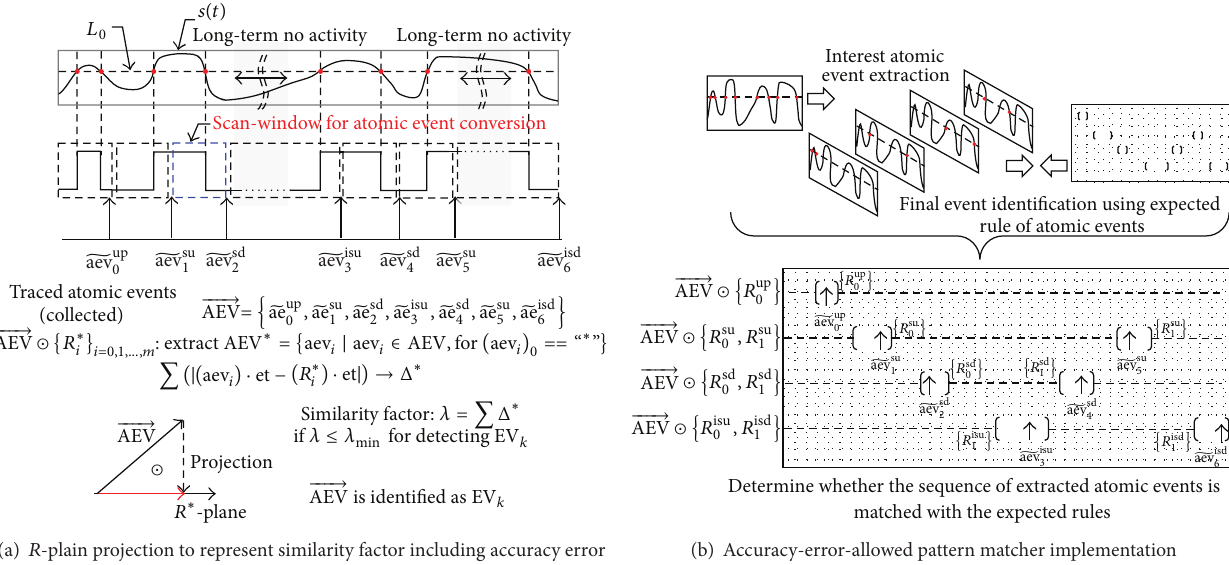
(b) Accuracy-error-allowed pattern matcher implementation Figure 8: Event-print identification for atomic event of